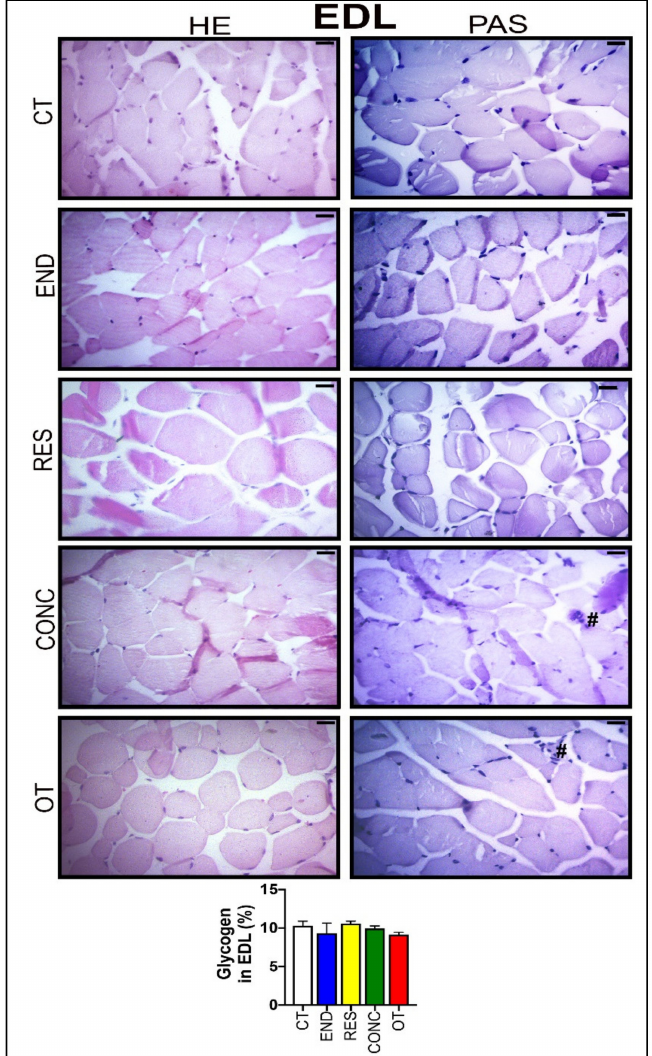
Figure 8. Histological characterization ( × 400) of EDL by hematoxylin-eosin (HE) and periodic acid Schi ff (PAS), and glycogen contents in the EDL. Bar = 20 µ m. Data correspond to the mean ± SEM of 4–5 mice / group. Polymorphonuclear cells (#). (Sedentary; control group); END (Endurance; submitted to the chronic endurance exercise protocol); RES (Resistance; submitted to the chronic resistance exercise protocol); CONC (Concurrent; submitted to the chronic concurrent exercise protocol); OT (Overtraining; submitted to the chronic exhaustive exercise